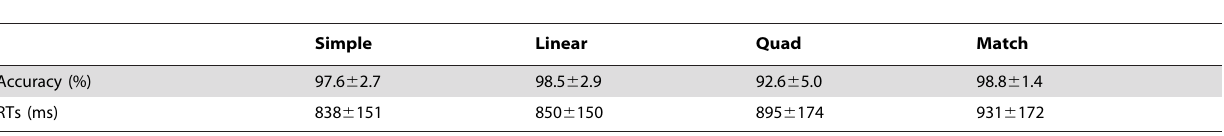
Table 2. Behavioral data under each condition.